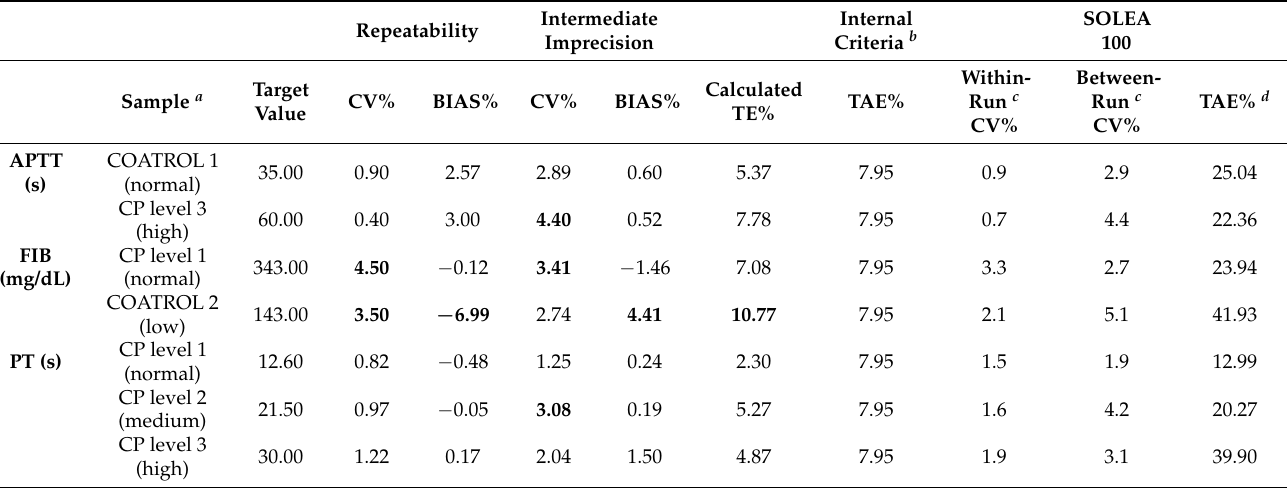
Table 3. Results of imprecision and bias studies on Biolabo Solea